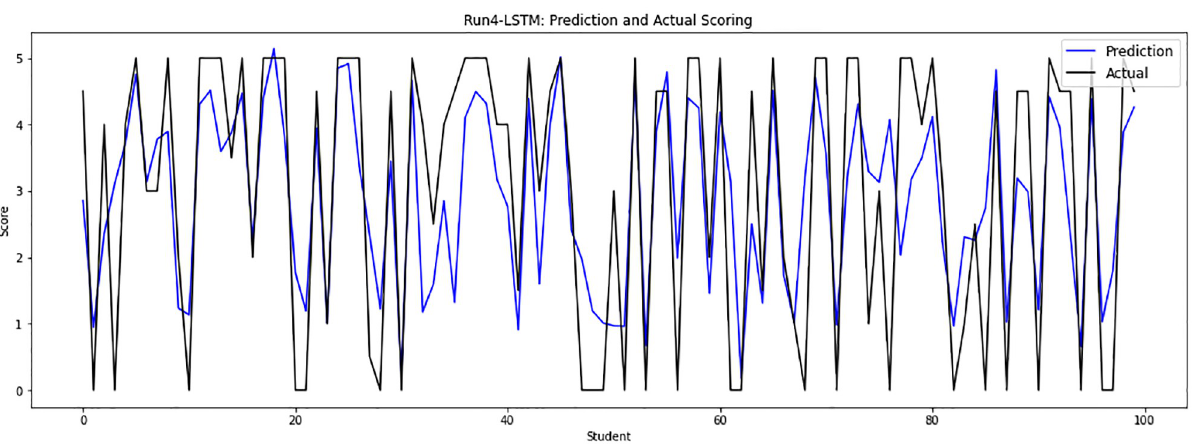
Fig 9. LSTM-GWO prediction and actual scores with experiment 4.